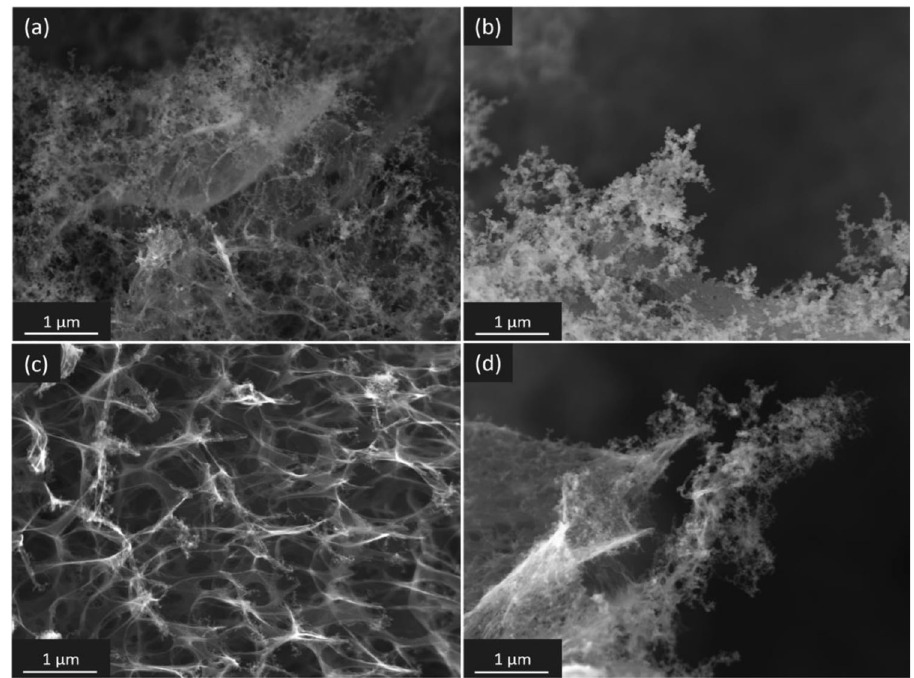
Fig. 2 Morphology via scanning electron microscopy. FE-SEM images of a graphene fl akes and b graphene/SiO x nanohybrids deposited on PDMS. FE-SEM images of c graphene fl akes and d graphene/SiO x nanohybrids, deposited on carbon fi ber